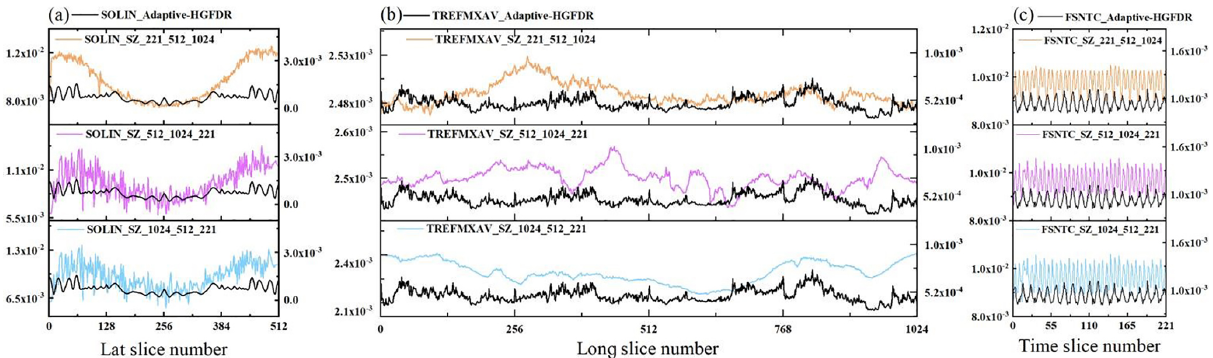
Figure 4. The compression error distribution along different dimensions. (a) The compression error distribution along latitude for SOLIN. (b) The compression error distribution along latitude for TREFMXAV. (c) The compression error distribution along latitude for